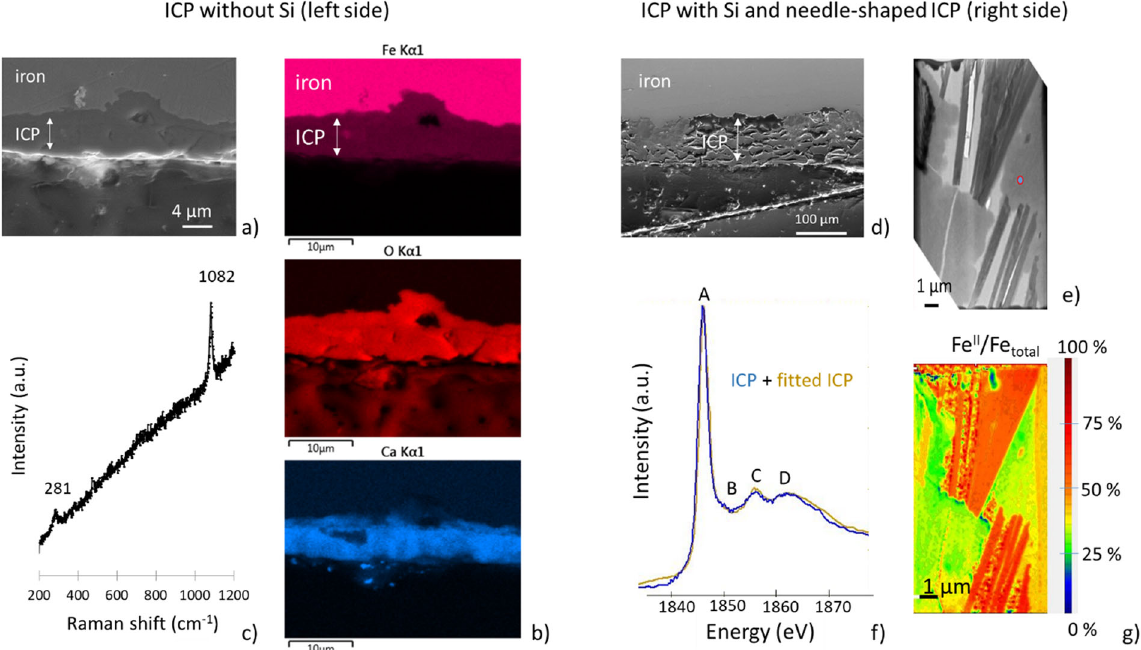
Fig. 7 ICP characterizations. a SEM micrograph, b SEM-EDS elemental mapping and c μRaman analyses of ICP on the left side, without Si. d SEM micrograph and e TEM micrograph of ICP on the right side, i.e., containing Si or needle-shaped ICP. f STXM spectra at Si K-edge on ICP with silicon (blue) and fi tted spectrum (brown). g quantitative Fe redox nanomapping obtained with STXM at Fe L-edge from micrograph in e